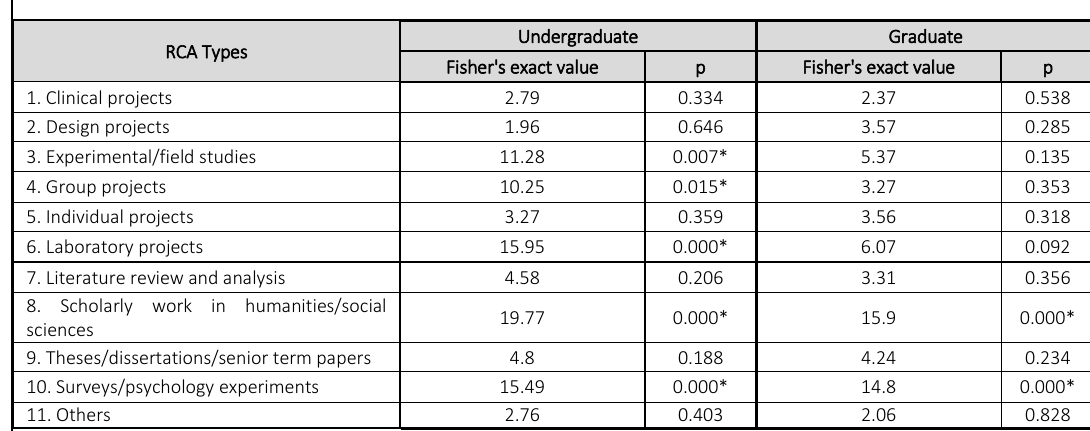
Table 1: Types of RCA conducted by faculty RCA